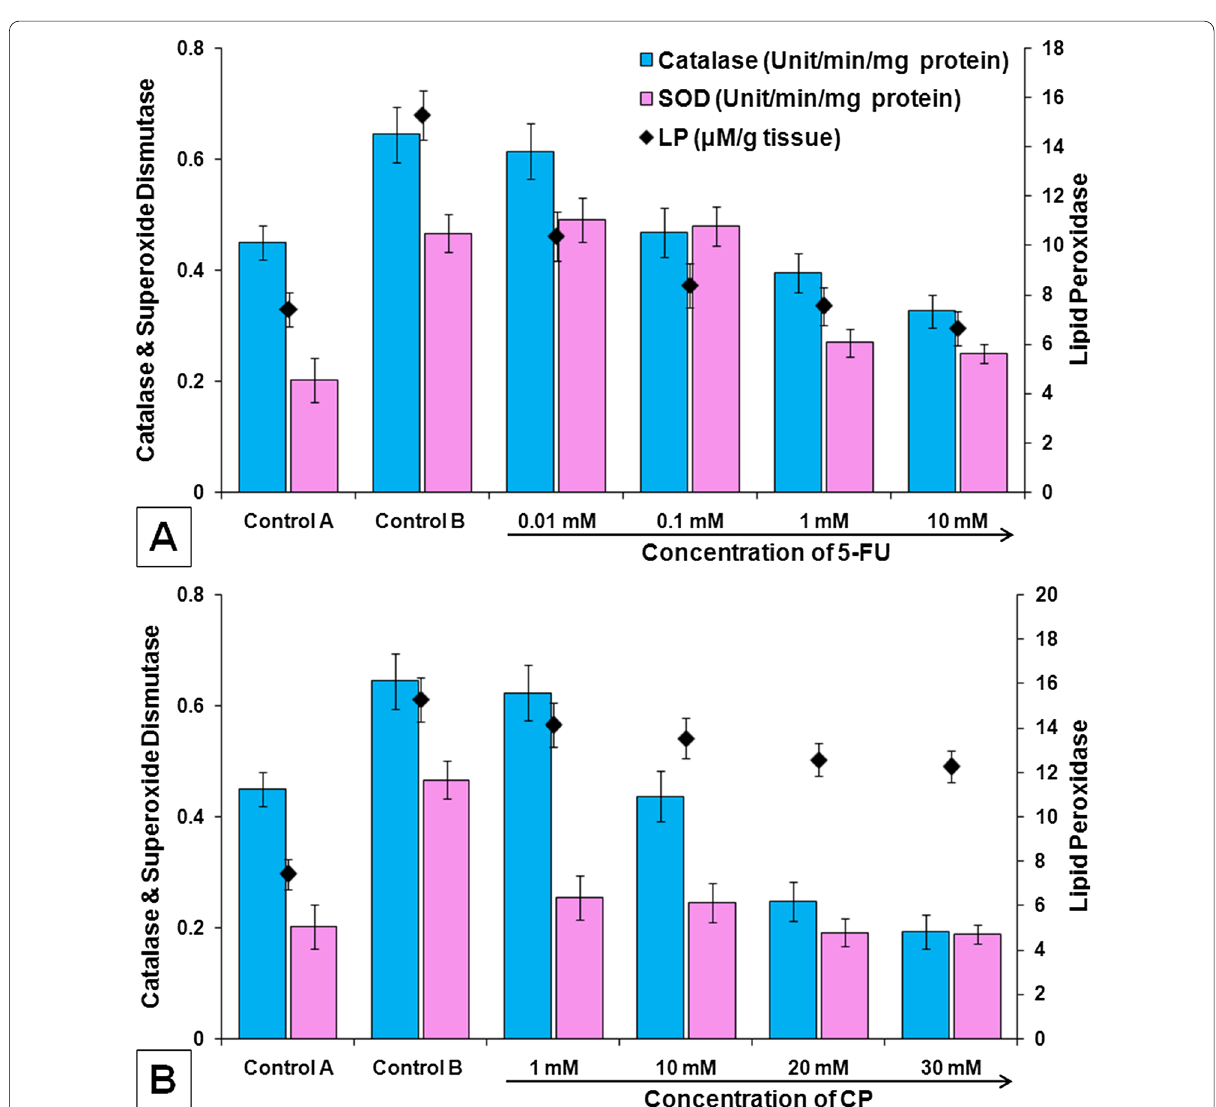
Fig. 6 Assessment of the activity of superoxide dismutase, catalase and lipid peroxidase of polyploid cells of Lathyrus sativus treated with colchicine followed by different concentrations of ( A ) 5-Fluorouracil and ( B )